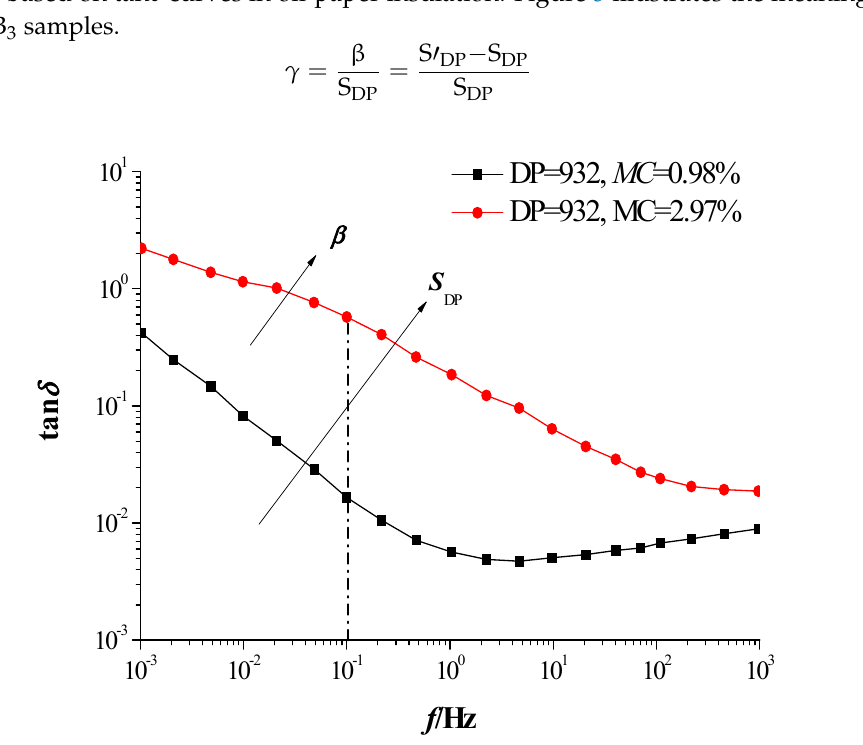
Figure 5. Description of moisture compensation factor.